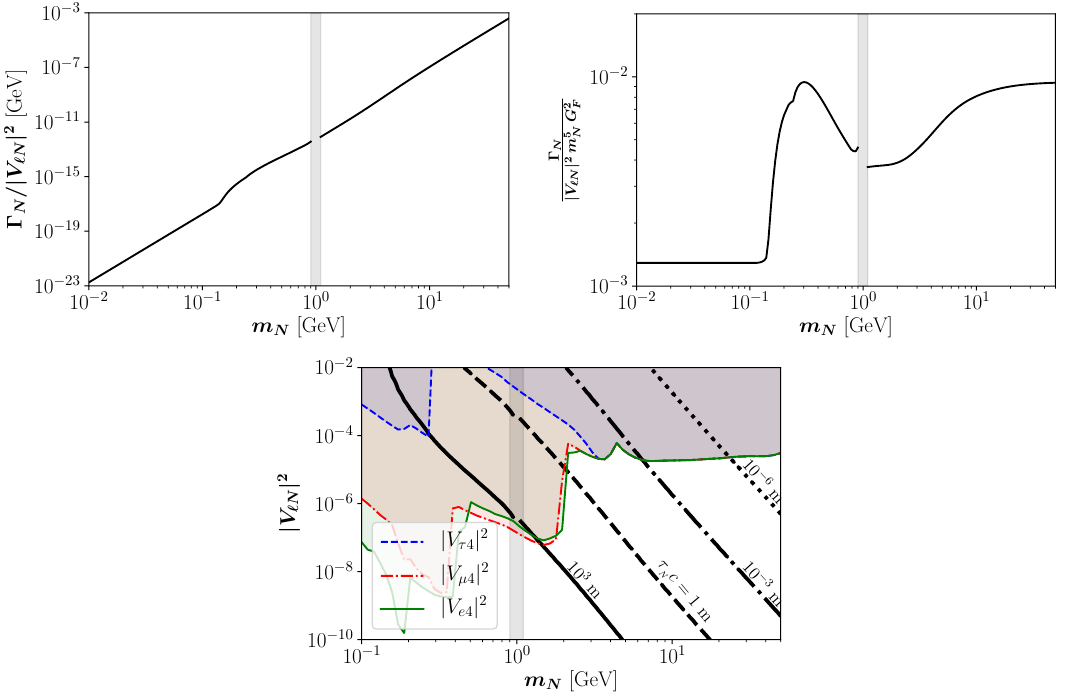
Figure 1 . Upper panels: (left) HNL total decay width (cid:0) N as a function of its mass m N and normalized to the mixings for m 5 G 2 . Lower panel: contour lines for the HNL decay length (cid:28) N F di(cid:11)erent